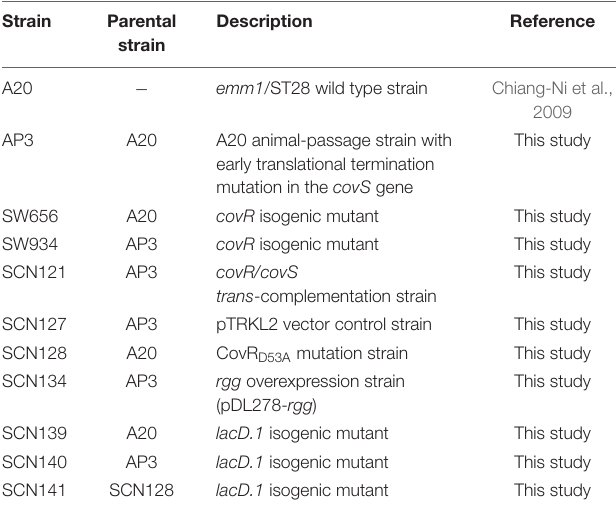
TABLE 1 | Group A Streptococcus (GAS) strains used in this